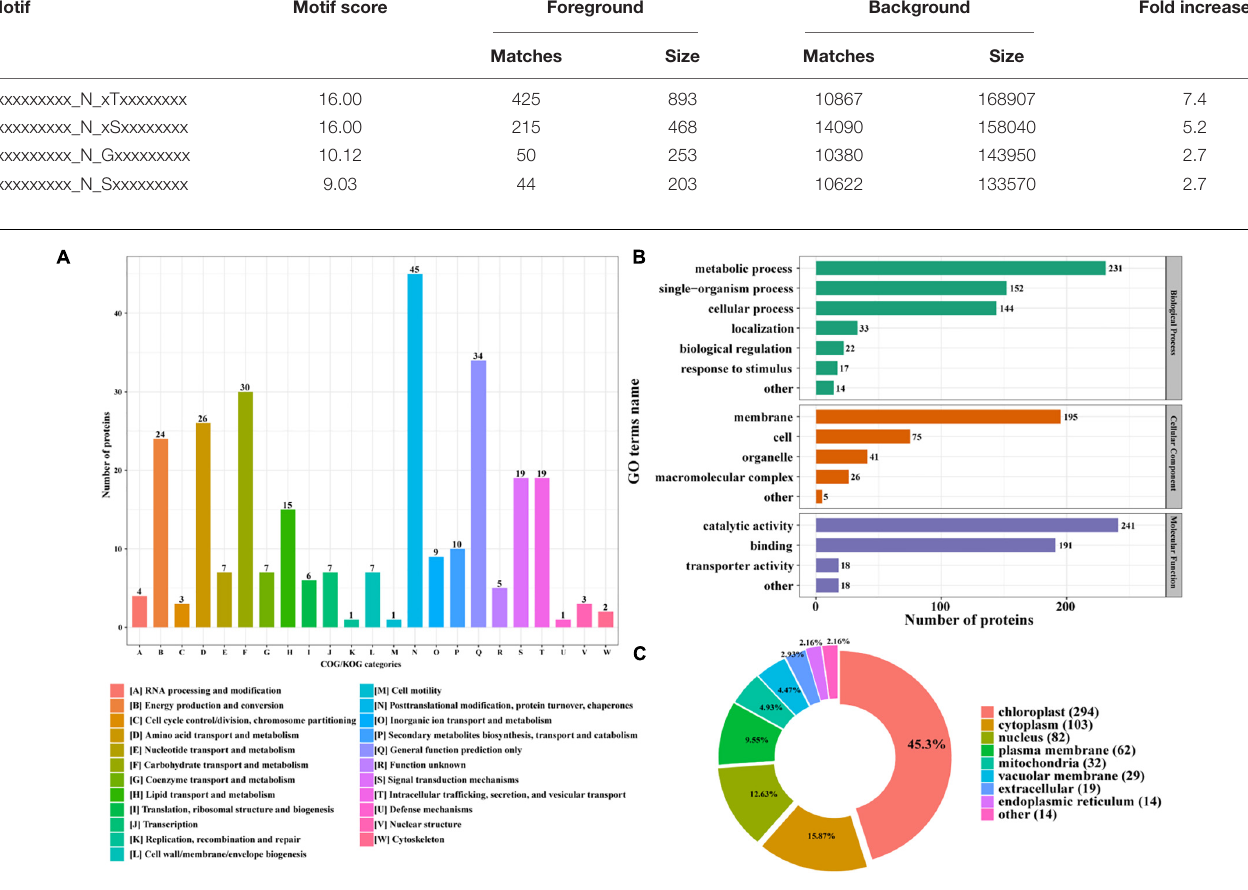
FIGURE 3 | Functional distribution and subcellular localization of the N-glycoproteins. (A) Clusters of Orthologous Group/Eukaryote Orthologous Group (COG/KOG) functional classification chart of N-glycoproteins. (B) Statistical distribution chart of N-glycoproteins under each GO category (second level). (C) Subcellular localization chart of